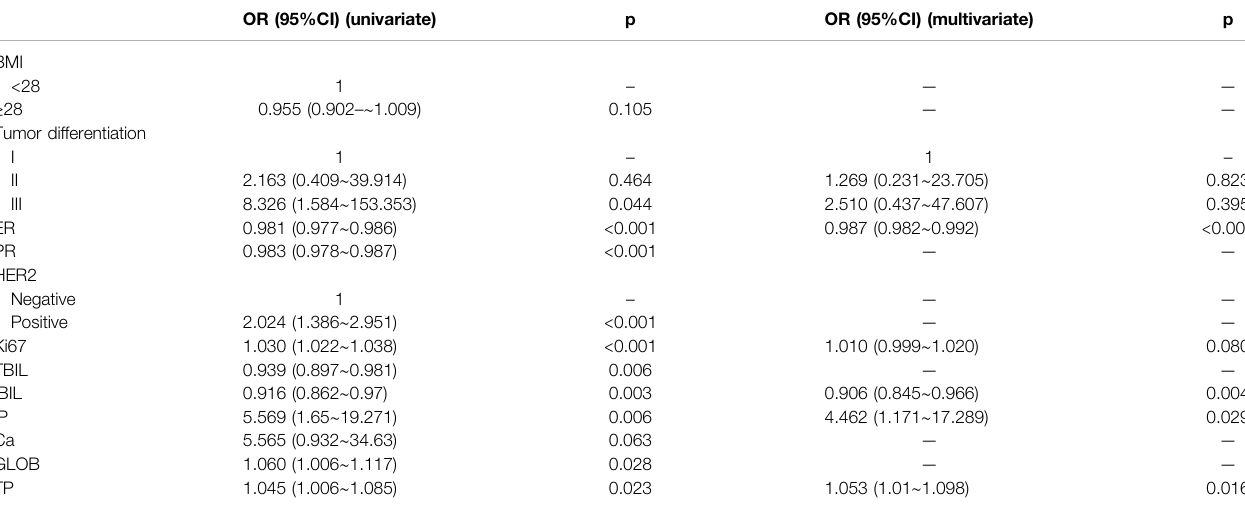
TABLE 4 | Correlative factors for TILs identi fi ed by univariate binary logistic regression and results of backward binary logistic multivariate logistic regression